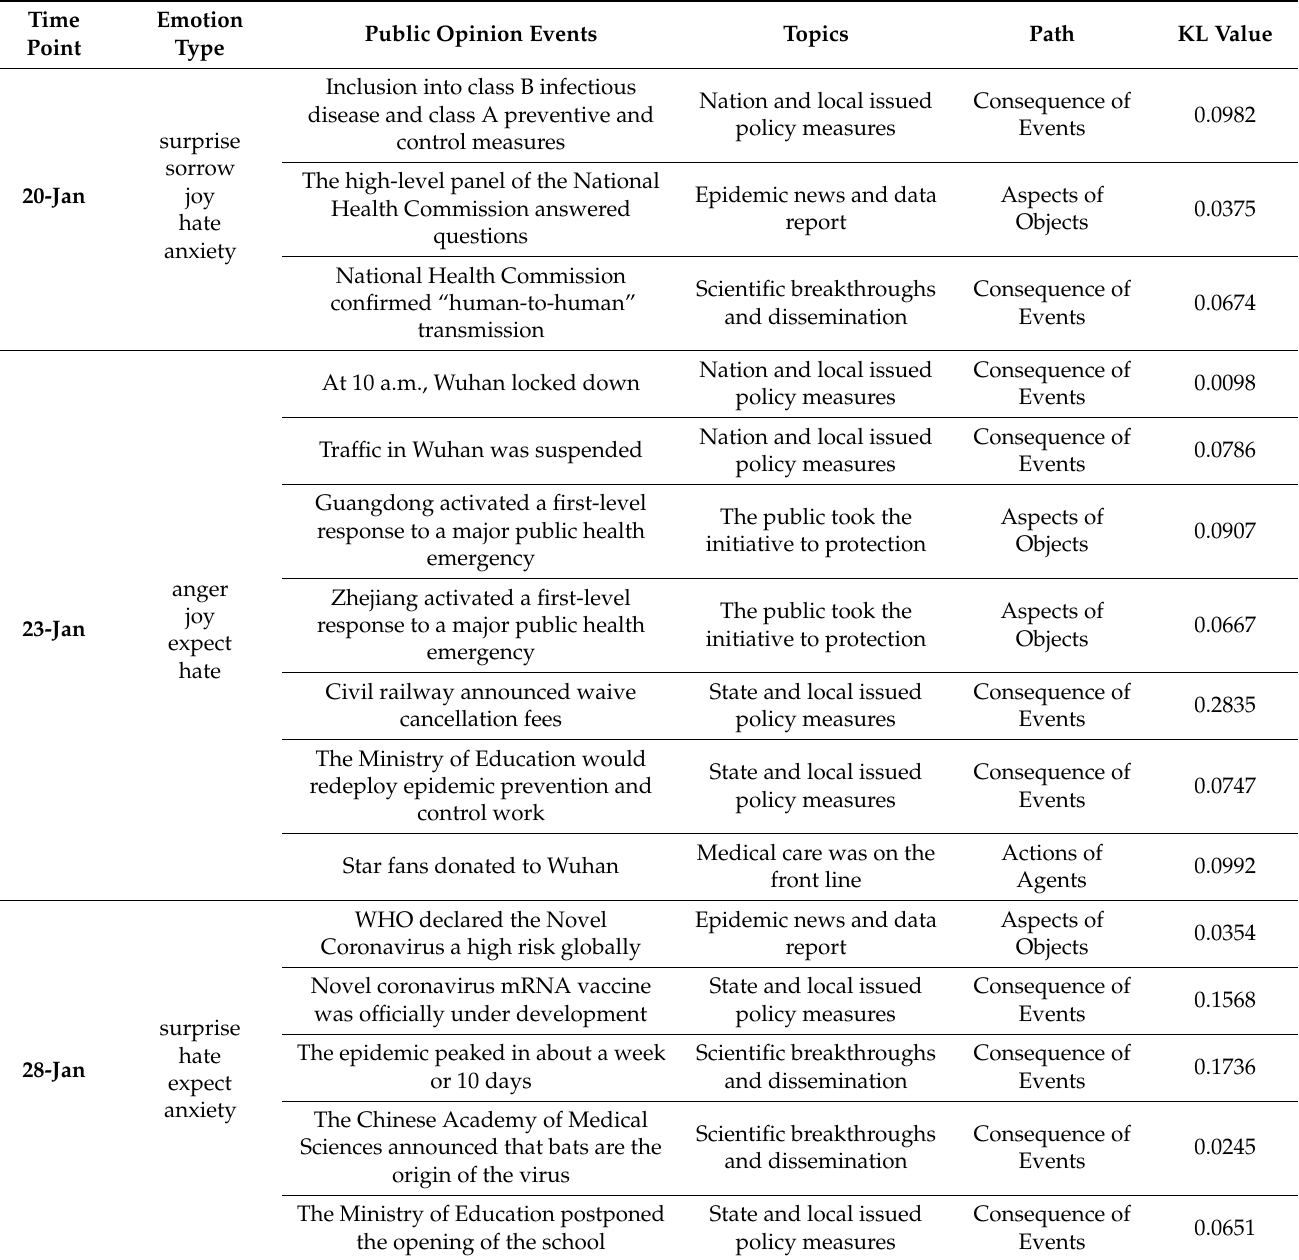
Table 4. Performance of KL Value of Candidate Events for Three